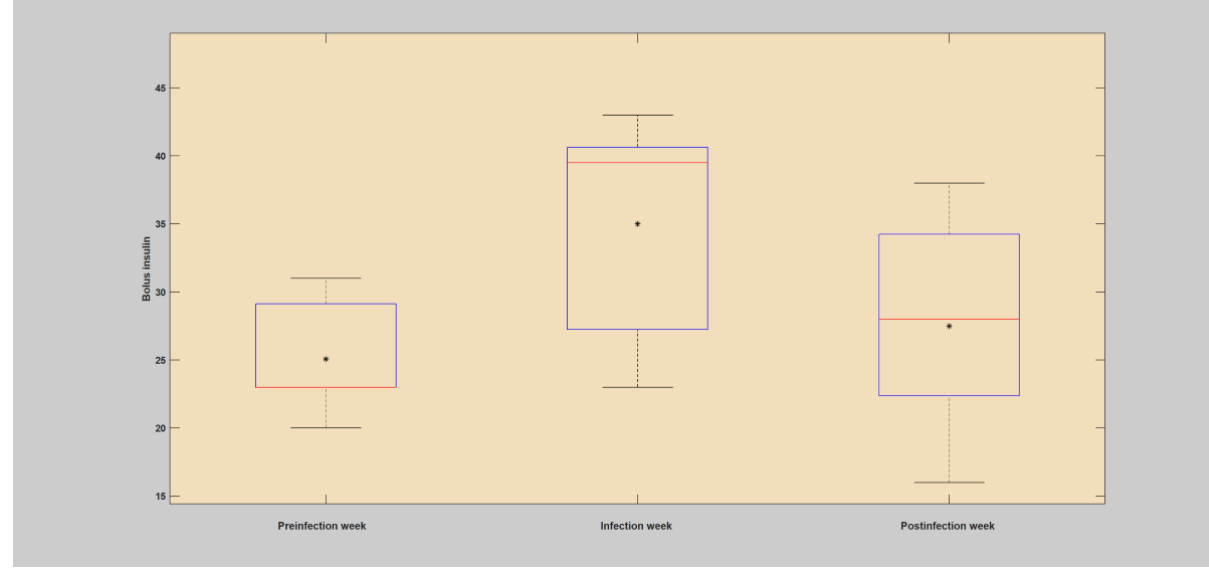
Figure 4. Analysis of total insulin (bolus) intake during preinfection week, infection week, and postinfection week based on the first case of infection (flu). The asterisk shows the mean value, and the red line depicts the median value for the